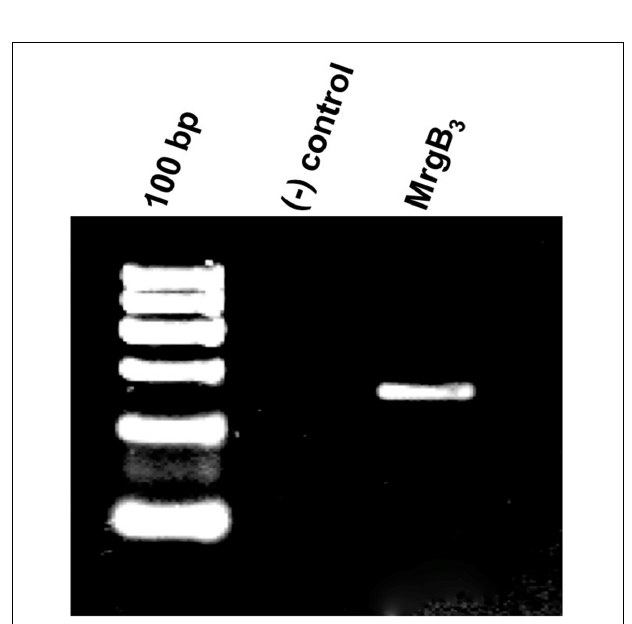
FIGURE 2 | Agarose gel electrophoresis showing the RT-PCR-product corresponding the presence of mRNA encoding the MrgB 3 receptor (259 bp) in rat peritoneal mast cells. No band is seen in the negative control [( − ) control] where mRNA was not reverse transcribed to cDNA prior to amplification. The experiment was performed in peritoneal mast cells from three